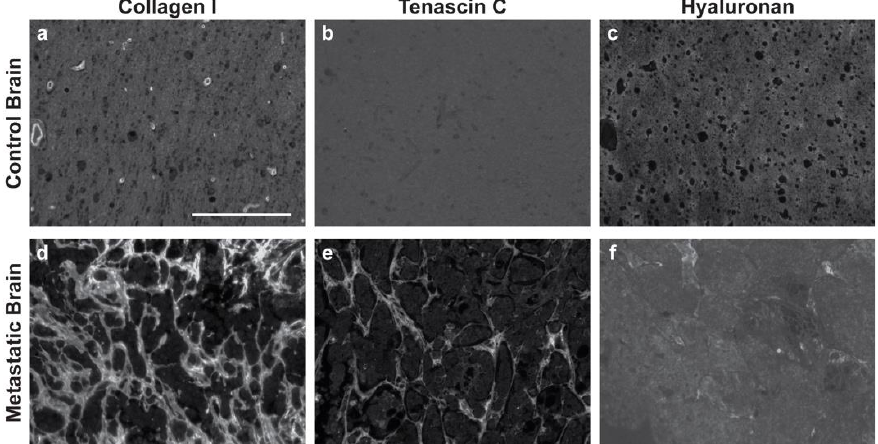
Figure 3. Breast cancer brain metastases exhibit remodeled extracellular matrix. Non-cancerous control brain resections ( a – c ) and breast cancer brain metastases resections ( d – f ) were stained for collagen I (anti-collagen I), tenascin C (anti-tenascin C), and hyaluronan (hyaluronic acid binding protein). Representative images were selected across six patients ( n = 6). Scale bar = 200 μm.